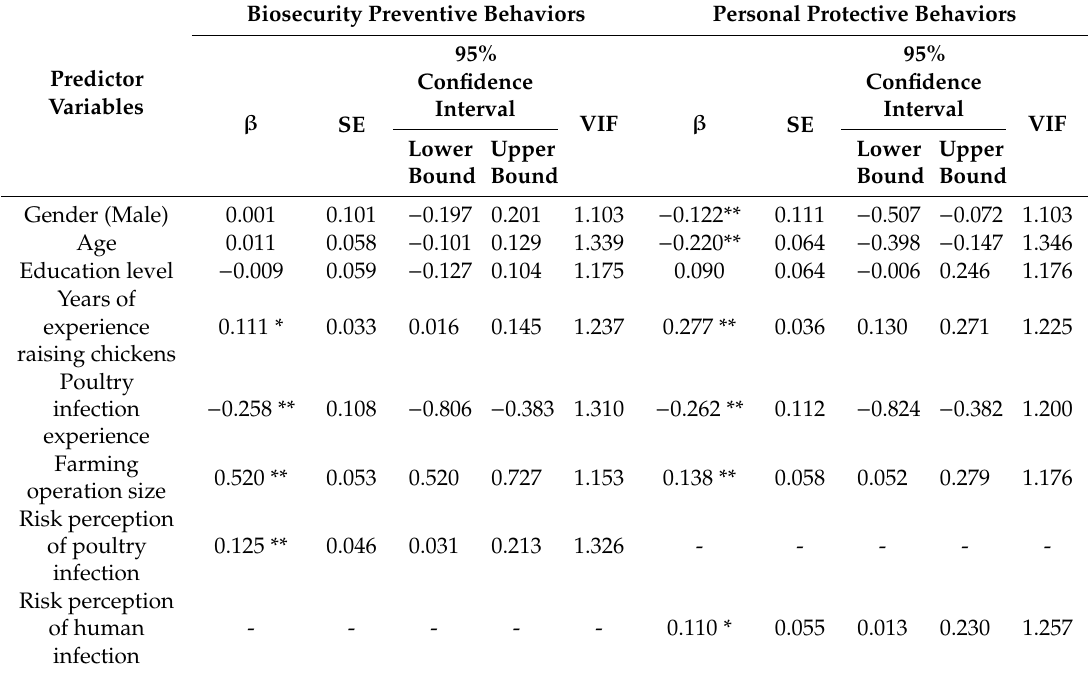
Table 3. Multiple regression coe ffi cients (standardized β , standard error) for socio–economic and risk perception variables associated with adoption of biosecurity preventive behaviors and personal protective